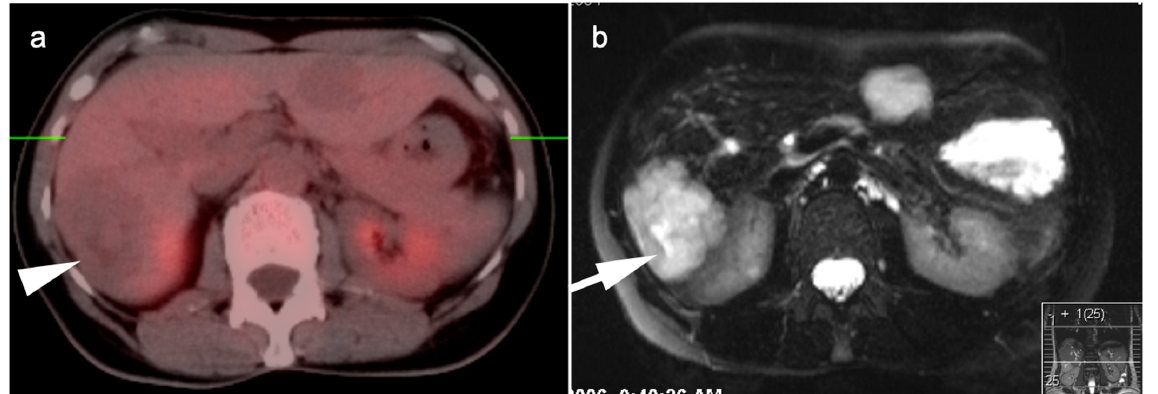
Figure 16. ( a ) A large cavernous hemangioma of the right lobe of the liver is isometabolic to the normal liver on axial fused FDG PET-CT; ( b ) On T2 axial MRI, this lesion shows typical bright signal seen in cavernous hemangiomas.